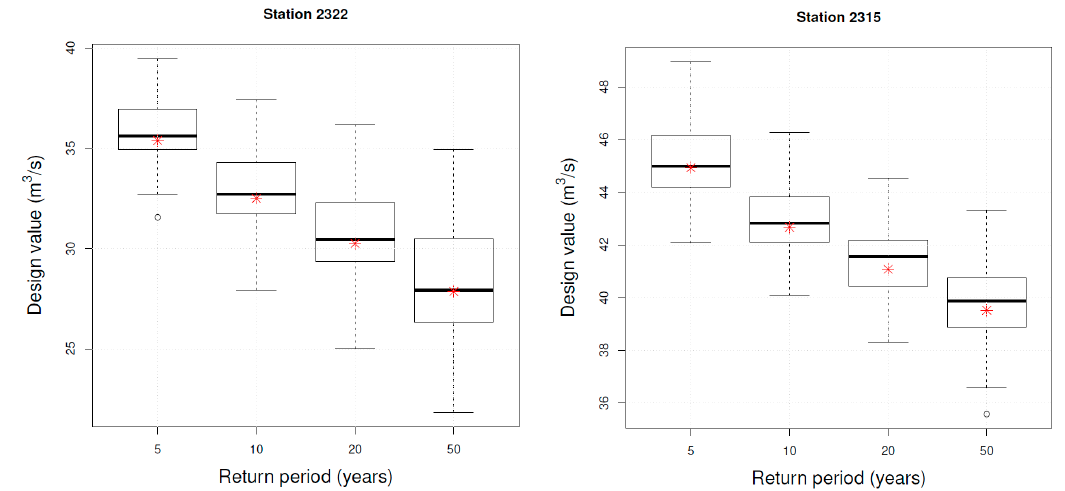
Figure 10. Lower Çoruh basin. Estimates of the univariate low-flow design values (red asterisks) associated with different return periods. Additionally shown are Monte Carlo boxplots providing an estimate of the corresponding uncertainty—see text.